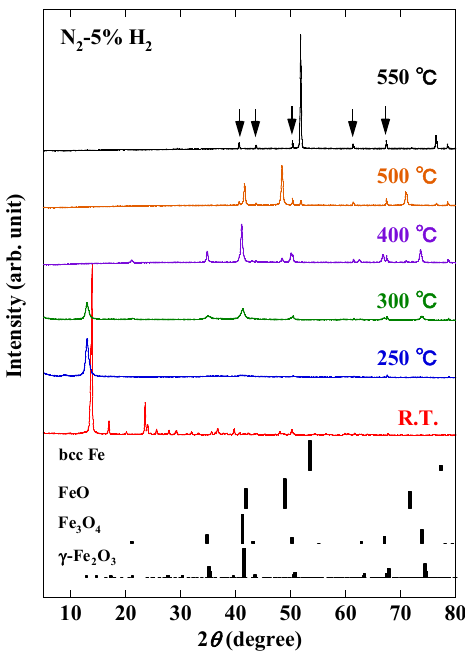
Figure 1. ( a ) Scanning electron microscopy (SEM) image of Fe-glycolate wires. ( b ) Mössbauer spectra at 77 and 300 K (recorded using magic-angle configuration).